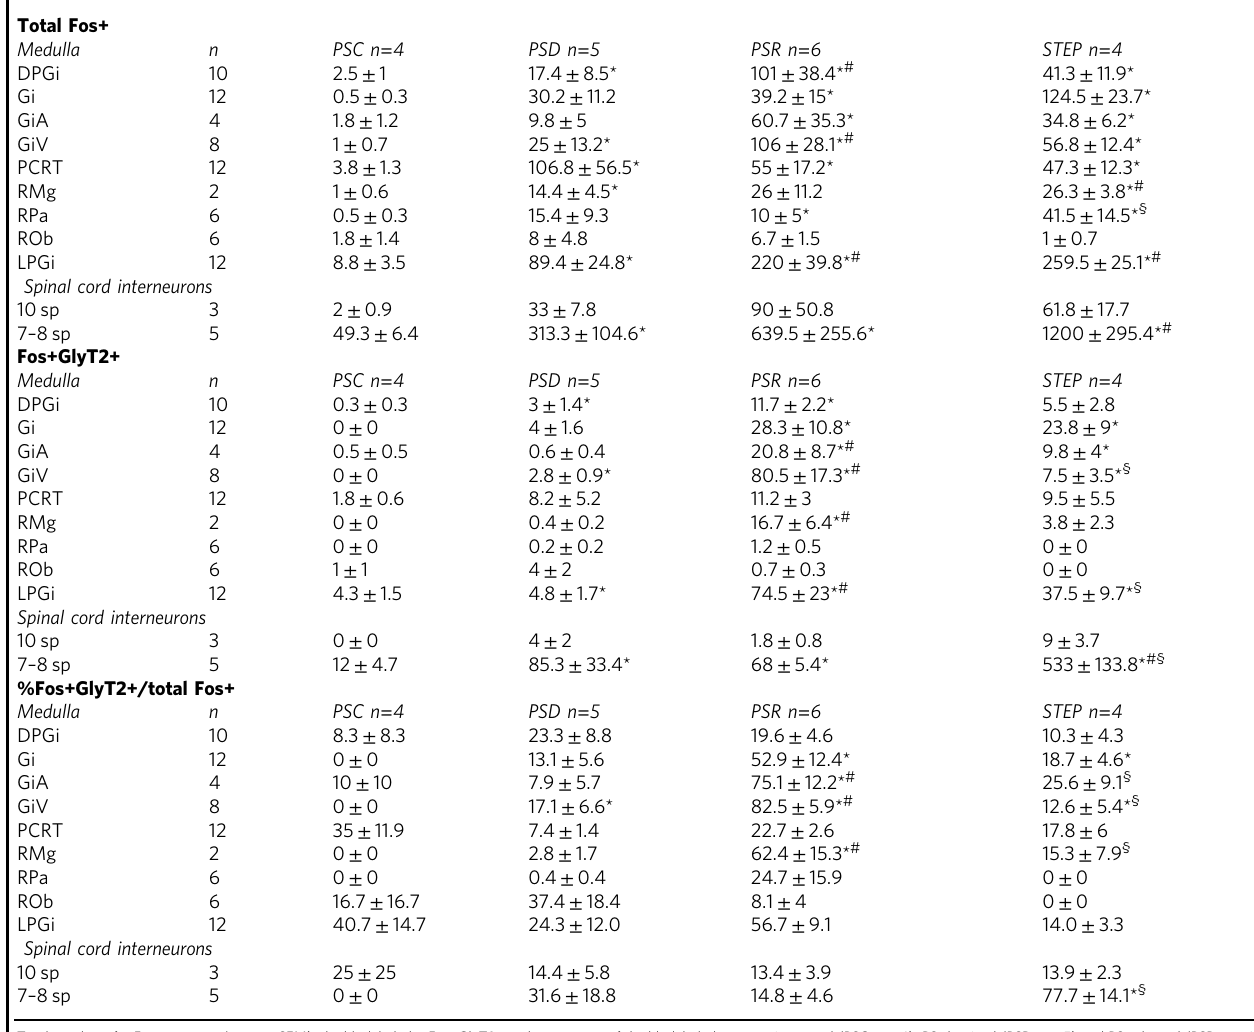
Table 1 Numbers of glycine neurons that expressed c-Fos in the medullary reticular formation and lumbar cord after PS recovery Total Fos+